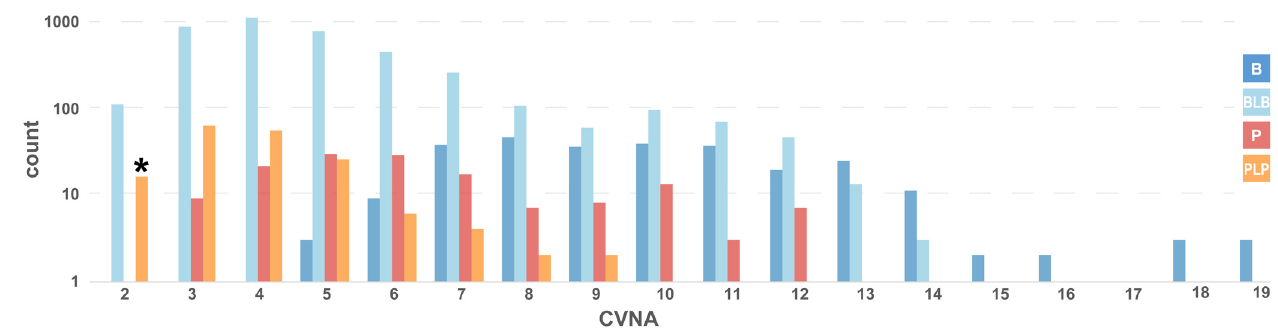
Figure 4. Conflicting interpretation of pathogenicity (CI) variants by number of clinical assertions (CVNA). CI variants with a Clinotator reclassification recommendation (CTRR) of three, counted by CVNA and colored by Clinotator predicted significance (CTPS). Blue represents Benign (B), light blue represents Benign/Likely benign (BLB), orange represents Pathogenic/Likely pathogenic (PLP) and red is Pathogenic (P). The asterisk denotes the column of 16 variants examined in Table 4.